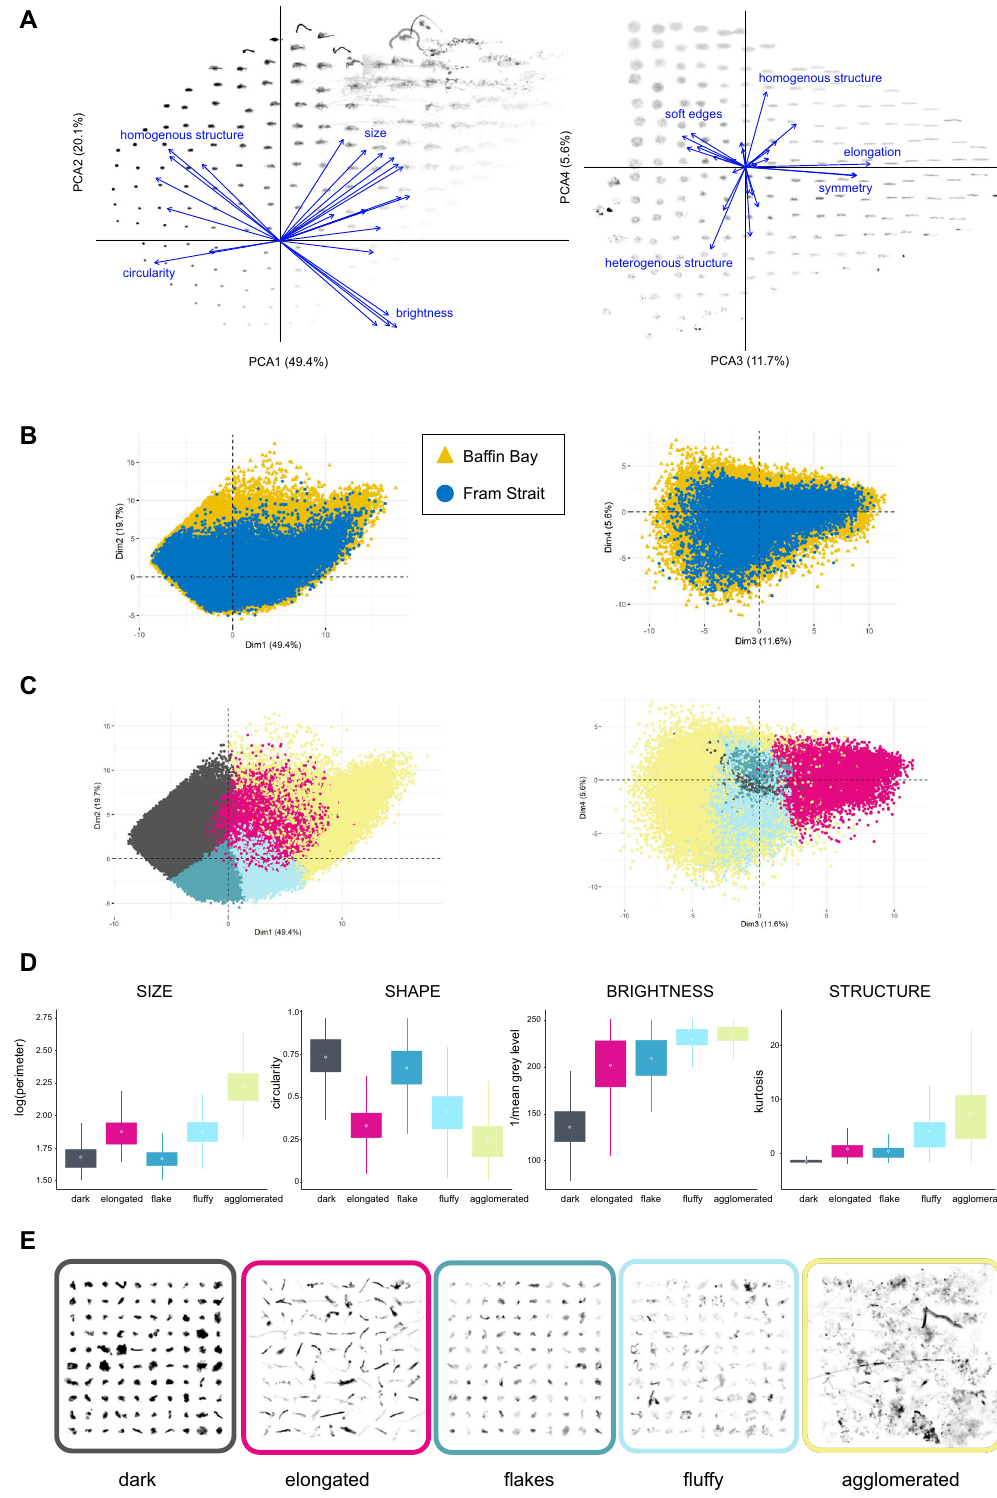
Fig. 2 Assignation of marine snow into morphotypes. A The PCA morphospace presenting correlations between 24 morphological characteristics of individual marine snow particles (arrows) and their exemplary appearance spread over the 1st and 2nd axes on the left and the 3rd and 4th axes on the right side. B The projection of 1,063,576 marine snow particles in the common morphospace of two sampling regions distinguished by color (blue: Fram Strait, yellow: Baf fi n Bay). C Categorisation of the marine snow into 5 morphotypes by k-means clustering (color-coded). D Box plots of the median values (size of the boxes present 25th and 75th quartiles, whiskers present distance from the quartile max/min to 1.5 * IQR (inter-quartile range)) of key exemplary morphological properties (perimeter, circularity, 1/grey level, kurtosis of grey level) characterizing 5 morphotypes. E Representation of example images of marine snow in each category